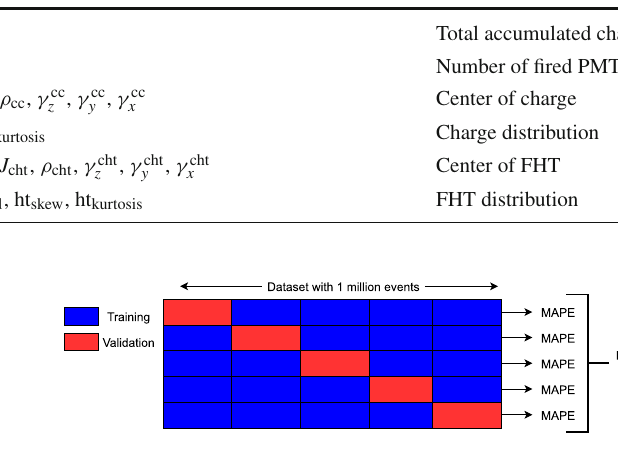
Table 1 List of all feature notations with brief descriptions. Here, n ∈ {2, 5, 10,